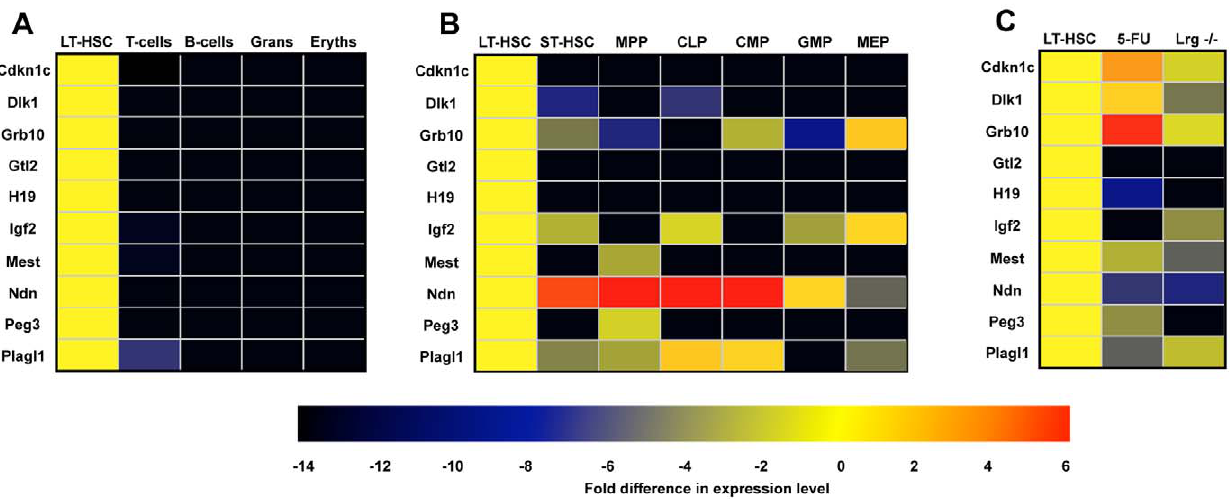
Figure 2. Real-time PCR analysis of imprinted gene expression in hematopoietic cells. Hematopoietic cell populations were isolated, and the expression of 10 core imprinted genes was determined by Q-RT-PCR. The data representing at least two independently isolated biological replicates for each population are shown as heat maps showing the fold difference in gene expression for each cell type compared to LT-HSCs. (A) Terminally differentiated cell populations (T-cells, B-cells, granulocytes, and erythrocytes) vs. HSCs. (B) Hematopoietic progenitor populations vs. LT- HSCs. (C) LT-HSC expression under conditions of acute (5-FU) or chronic ( Lrg47 2 / 2 ) proliferative stress vs. quiescence. Proliferating LT-HSCs were collected on day 6 post 5-FU treatment or from Lrg47 2 / 2 mice, and imprinted gene expression was determined by Q-RT-PCR.